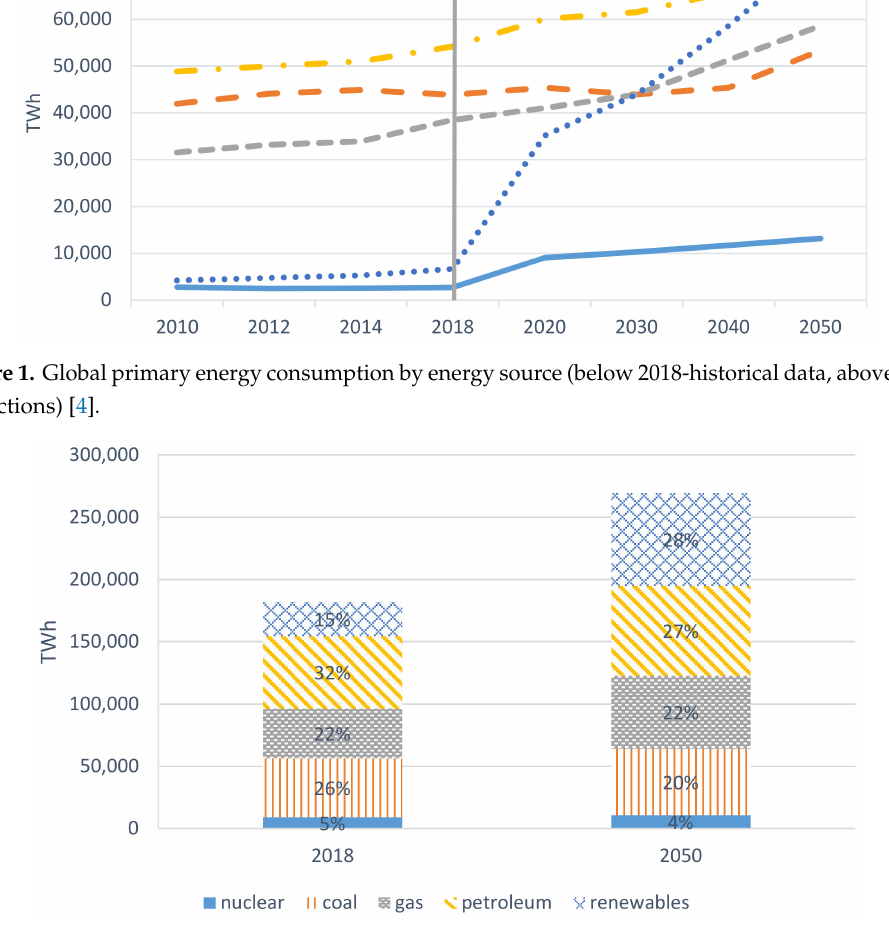
Figure 2. Absolute values and percentage shares of energy sources in global consumption